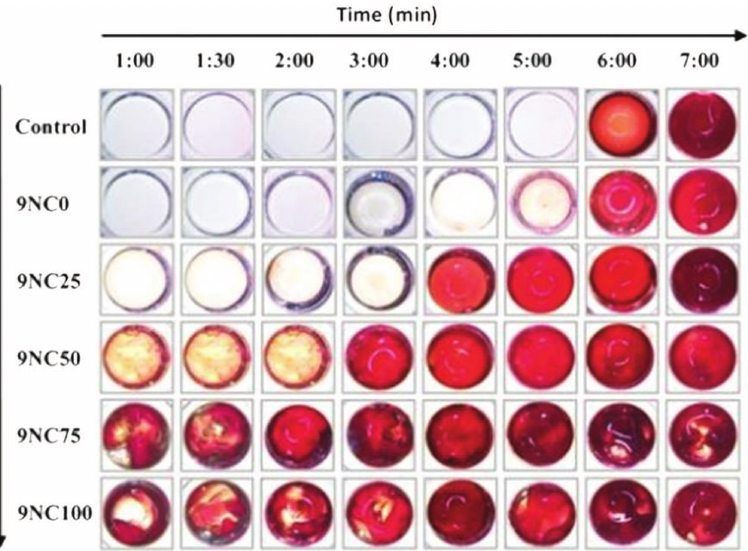
Figure 14: The clot formation as a function of time and nanocomposite composition. xNCy (“x” represents the total solid weight percent and “y” is percent of the total solid weight percent that is nanoplatelet). This is an unoflcial adaptation of Ref. [38] that appeared in an ACS publication. ACS has not endorsed the content of this adaptation or the context of its use.